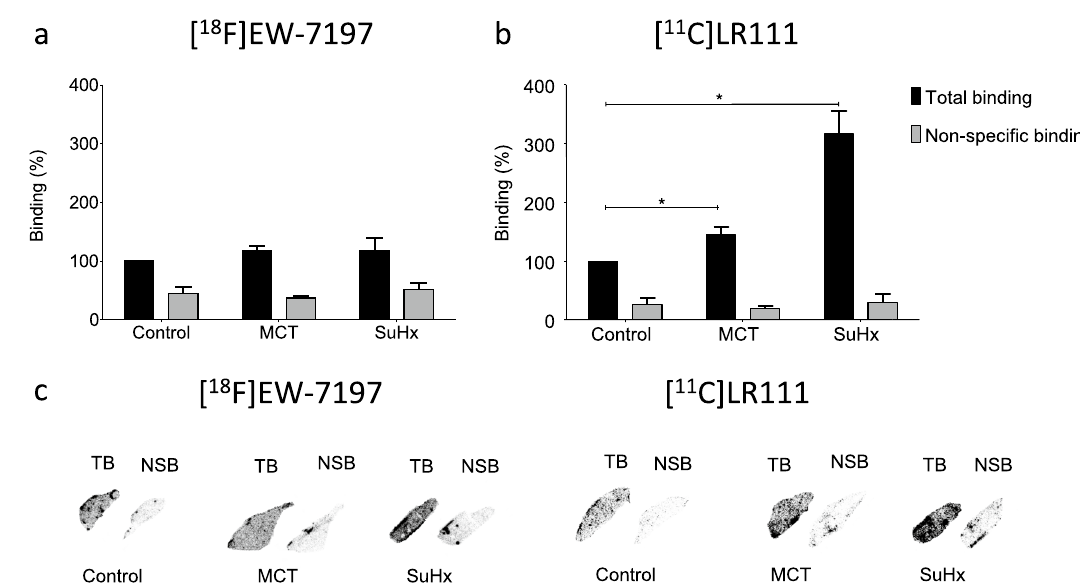
Fig. 4 Autoradiography results: a per cent binding in control lungs ( n 3), MCT lungs ( n 3) and SuHx lungs ( n 3) for [ 18 F]EW-7197; b per cent = = = binding in control lungs ( n 3), MCT lungs ( n 3) and SuHx lungs ( n 3) for [ 11 C]LR111; c Representative images of lung tissues for both tracers = = = showing total binding (TB) and non-specific binding (NSB) in control lungs, MCT lungs and SuHx lungs. Error bars represent standard deviations. NSB images were obtained after blocking with SB431542. * represents a significant difference with SuHx lungs and MCT lungs ( p <